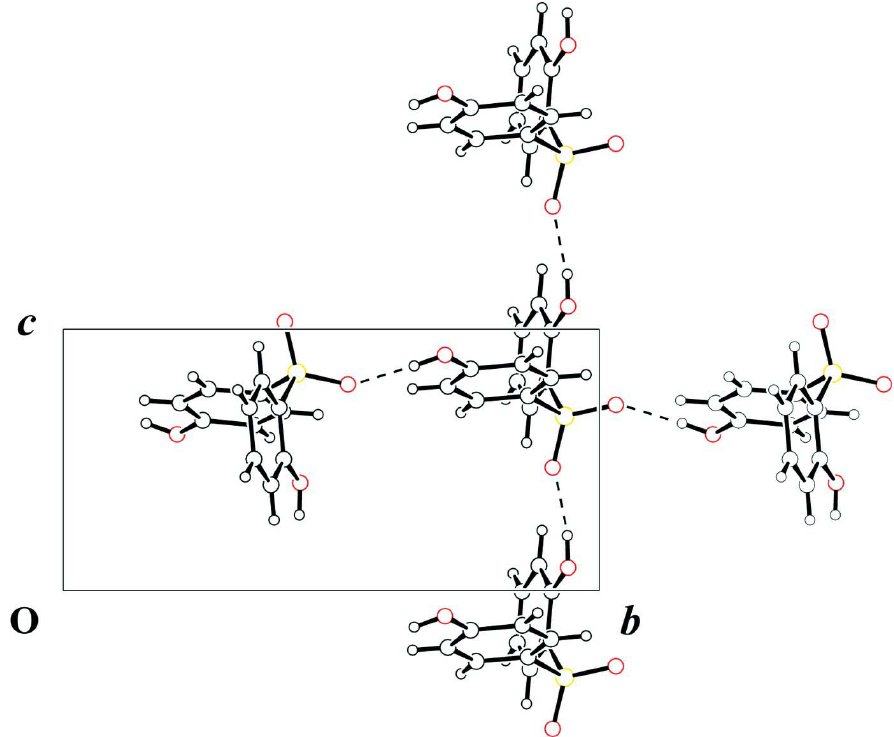
Figure 2 Projection of the structure of (I) onto the b and c plane, showing O—H···O intermolecular hydrogen bonds in dotted lines. One molecule is hydrogen-bonded to four different molecules along the b and c